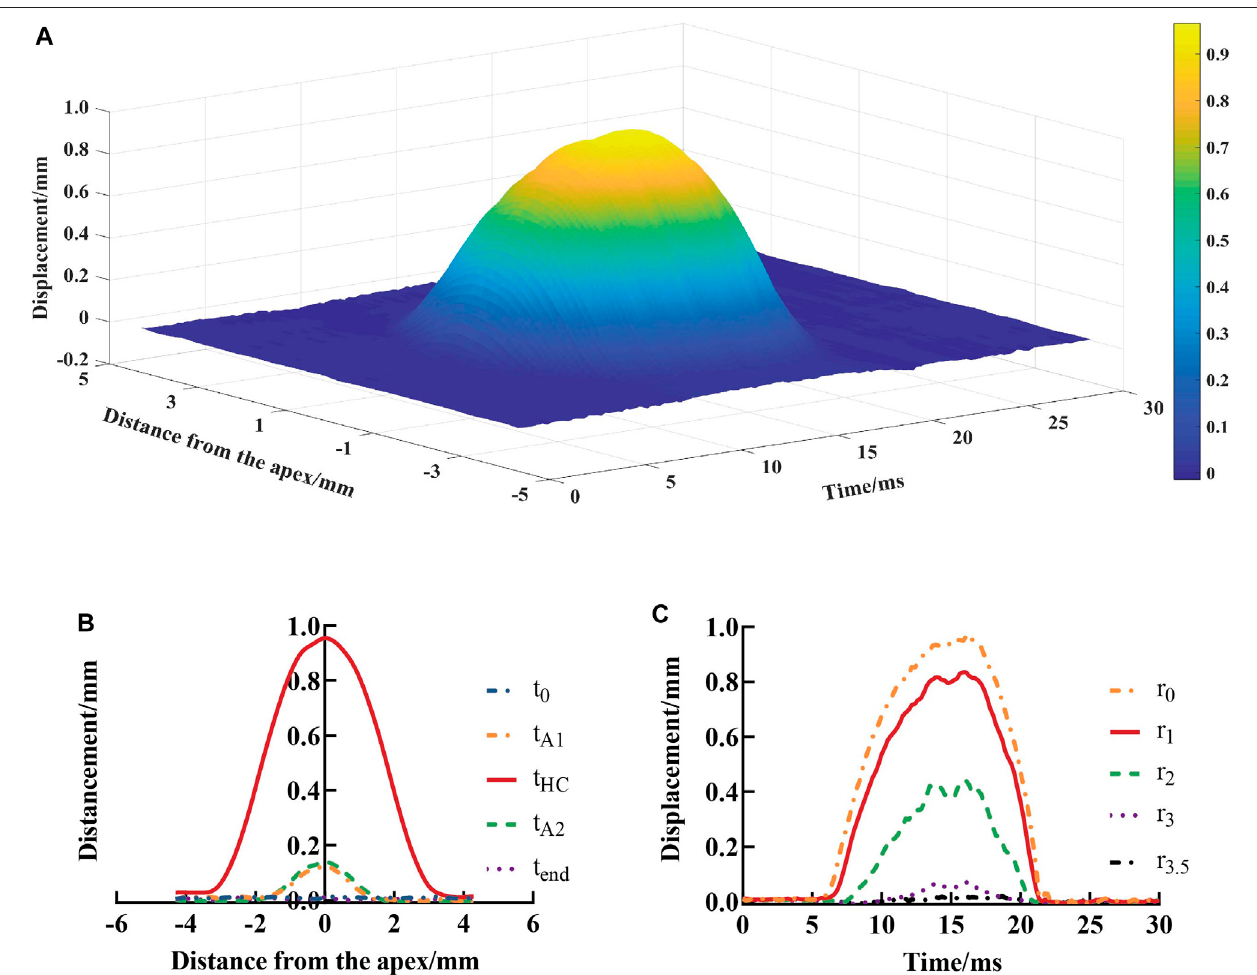
FIGURE 5 | Vertical displacements of the anterior surface of the cornea at each position and test time point (A) , spatial distribution (B) , and temporal variation (C) . t 0 , t A1 , t HC , t A2 , and t end represent the time at initial state, fi rst applanation, highest concavity, second applanation, and end state, respectively; r l represents the distance from the corneal apex which was l ( l (cid:1) 0, 1, 2, 3, 3.5) mm.